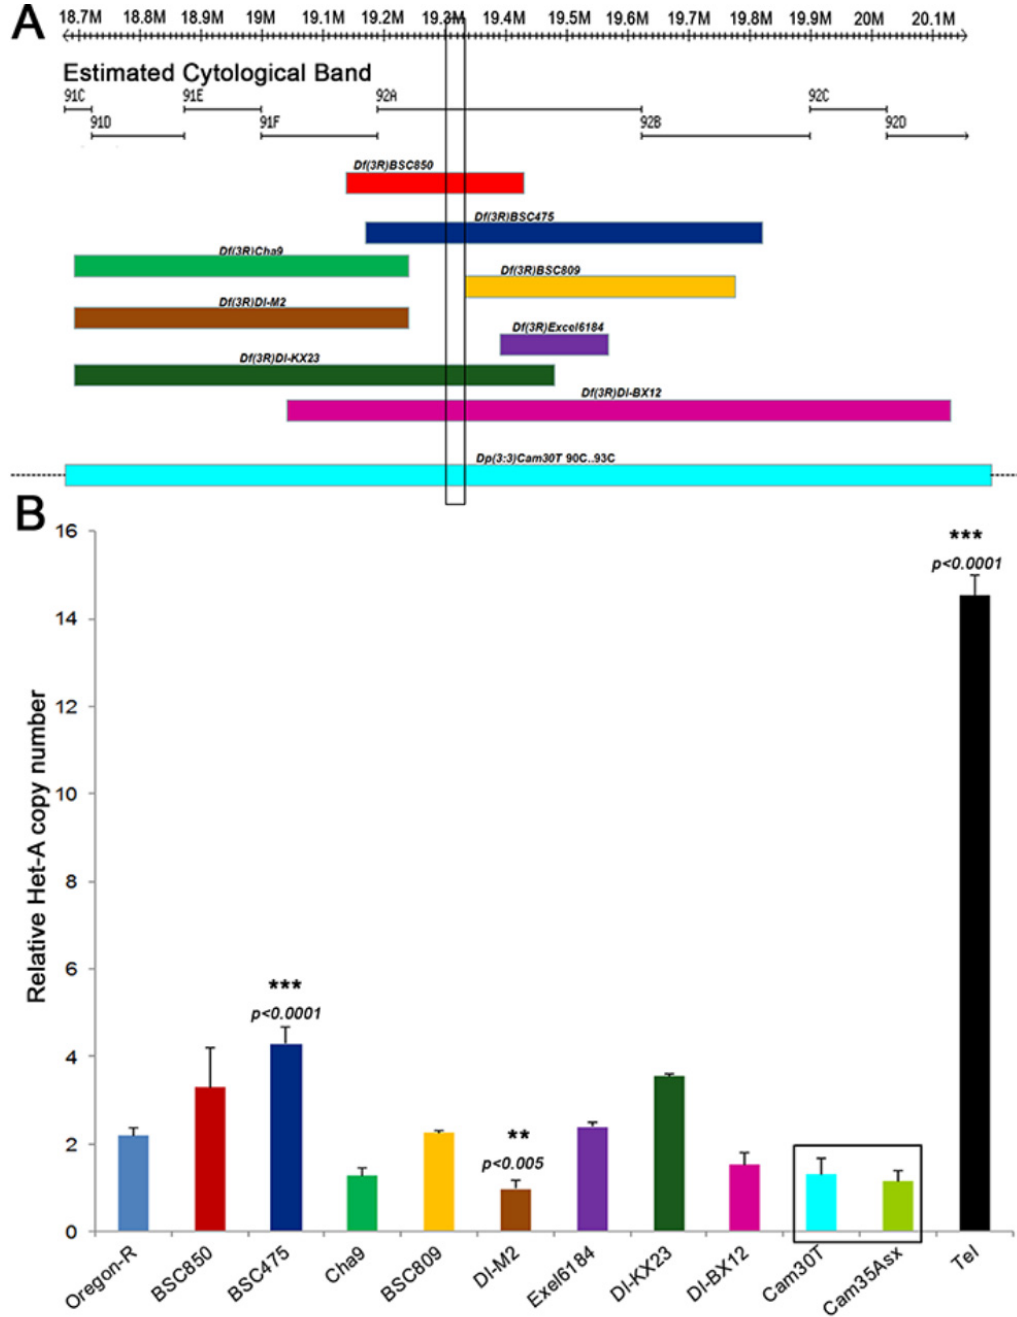
Figure 3. Dosage effects of Tel on HeT-A copy number. ( A ) The cytogenetic and physical map of genomic region 91C-91D is displayed, highlighting the 15 kb Tel 1 region as a vertical box. The lower part of the panel shows the extent of chromosome deficiencies. The bottom rectangle, Dp(3:3)cam30T , is a duplication for this region. Dotted lines beyond this rectangle show that the duplication extends beyond the represented region. ( B ) Shows the relative HeT-A copy number in stocks of the aberrations shown in A. The highlighted box represents a duplication that includes mapped region ( Dp(3;3)cam30T covers 90C-93C) and another duplication of a neighboring region of the genome (Dp(3;3)cam35 covers 67C5-69A5) as a control. The mean from three replicates is represented here and error bars represent standard deviation. ** p < 0.005; *** p < 0.0001, one-way ANOVA with Sidak